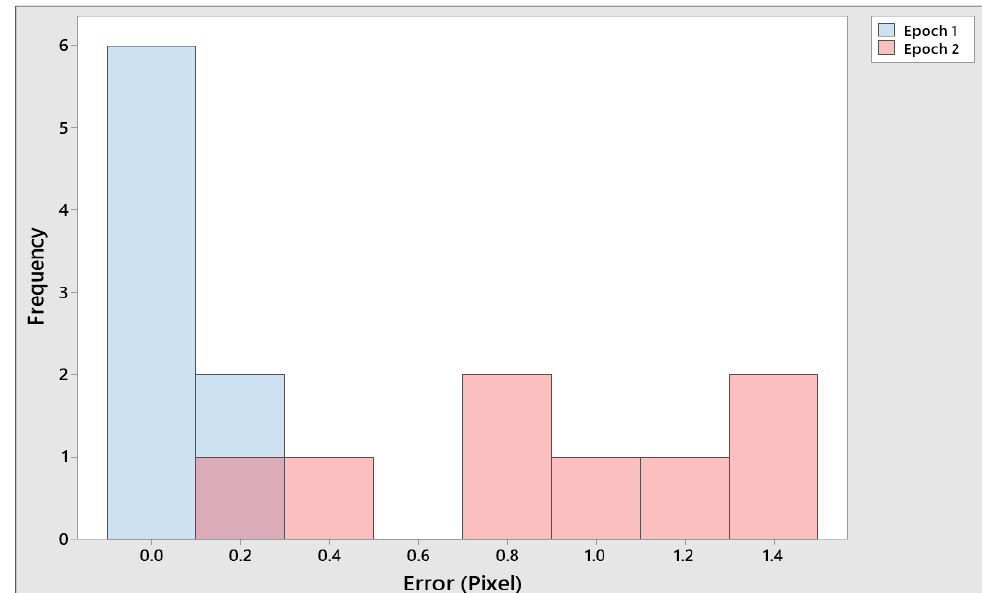
Figure 9. Histogram of the image geo-referencing error; ( A ) Error in pixels for Epoch 1; ( B ) Error in pixels for Epoch 2.